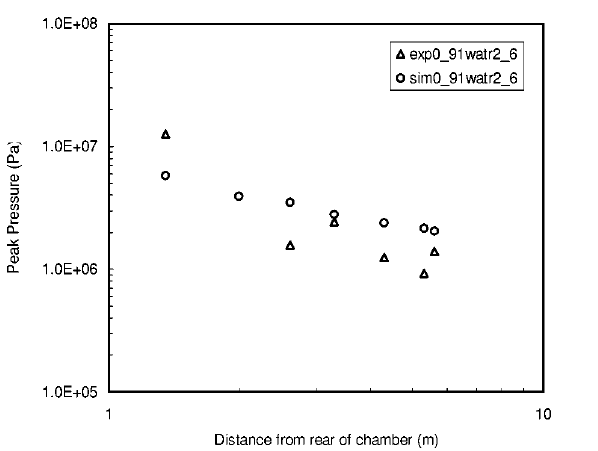
Fig. 7. Comparison between experiment and computation for 0.91 kg C4 charge detonation with water ( R = 2 : 6).